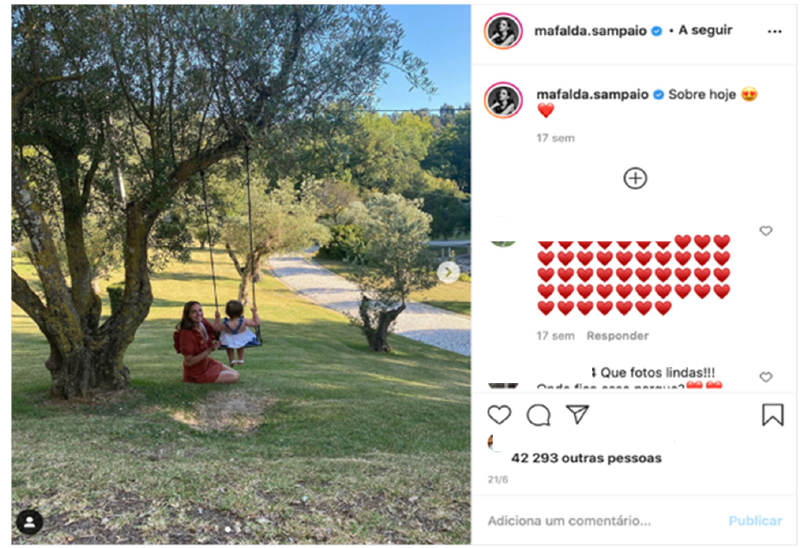
Figure 13. Example of speech—“Daily situation”; Instagram @mafalda.sampaio, Post, 21 June 2020.